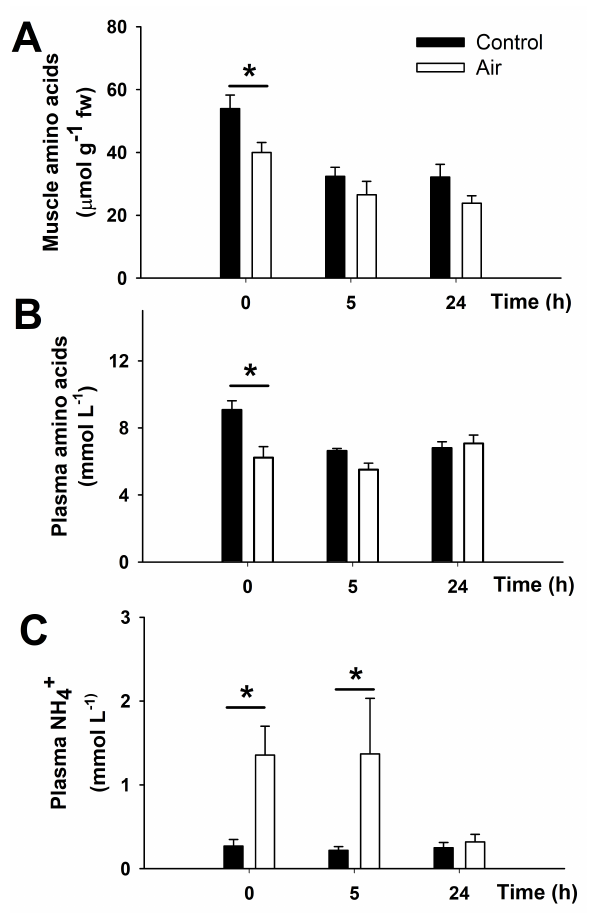
Figure 1. Amino acid consumption and NH 4+ production in S. canicula after air exposure. Mus- cle free amino acids (in µ mol g − 1 wet weight; ( A )), and plasma free amino acids (in mmol L − 1 ; ( B )) and NH 4 + (in mmol L − 1 ; ( C )) in S. canicula after air exposure and recovery. Data are expressed as mean ± s.e.m. Asterisks (*) indicate significant differences between both groups at each time ( p < 0.05, n =